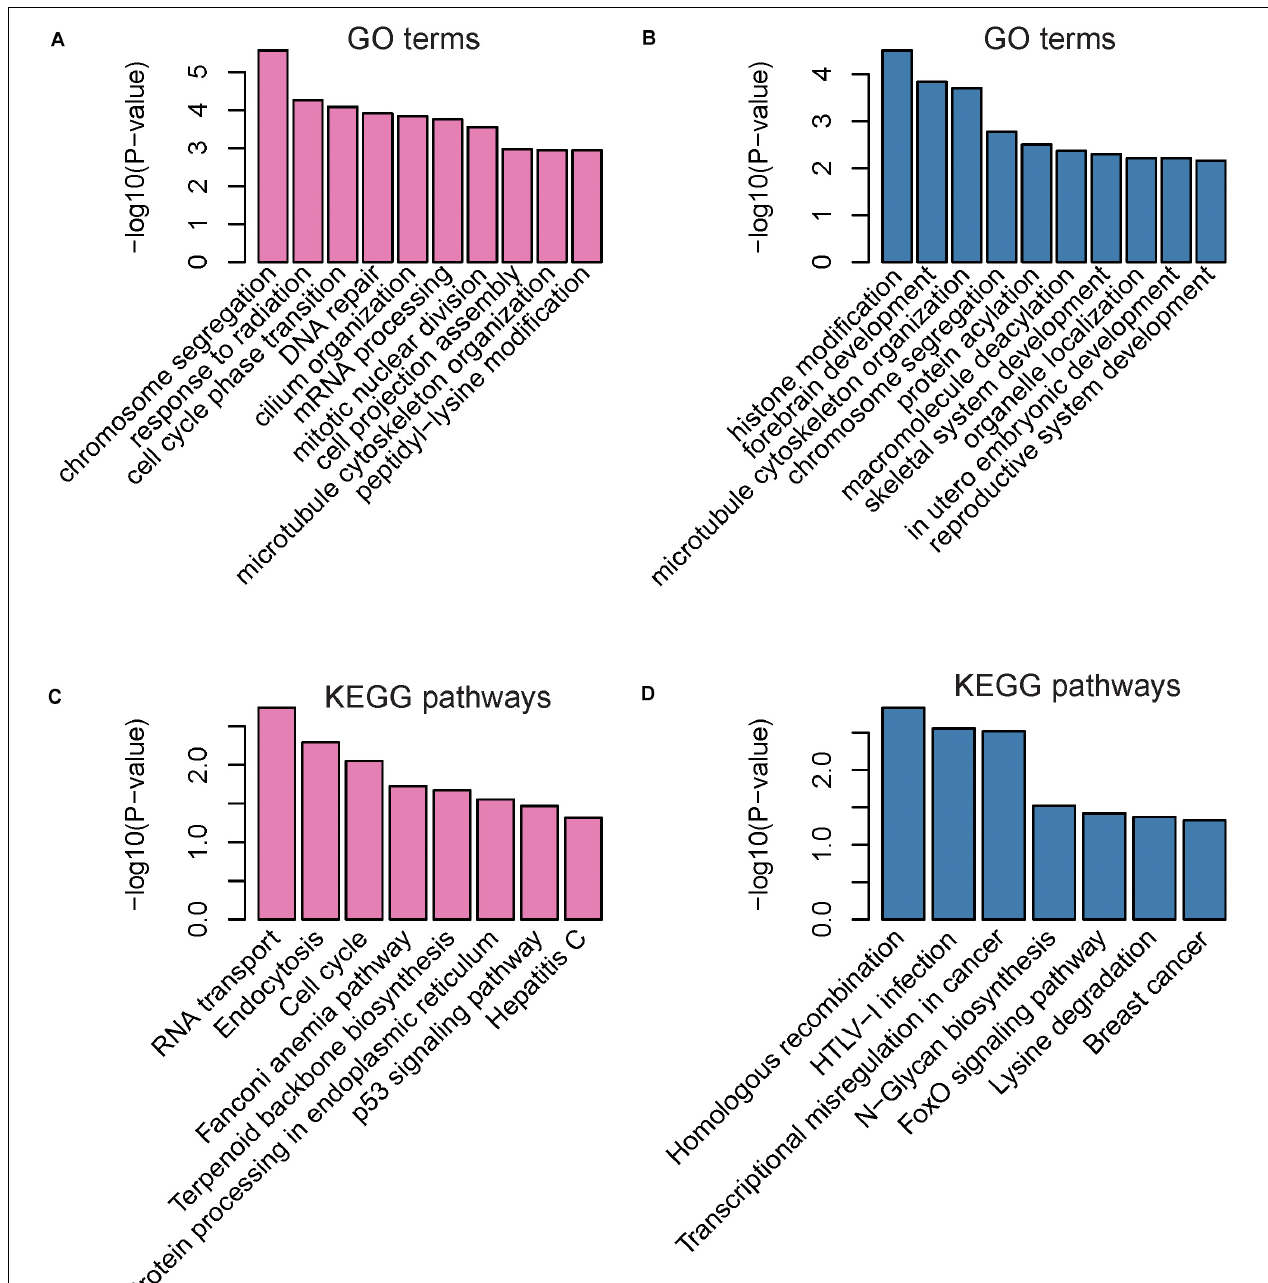
FIGURE 3 | Gene Ontology (GO) and Kyoto Encyclopedia of Genes and Genomes (KEGG) enrichment of parental genes of dysregulated circRNAs The enriched GO terms and KEGG pathways are presented in (A–D) . The pink and blue bars represent the GO terms or KEGG pathways enriched by parental genes of up-regulated and down-regulated circRNAs,